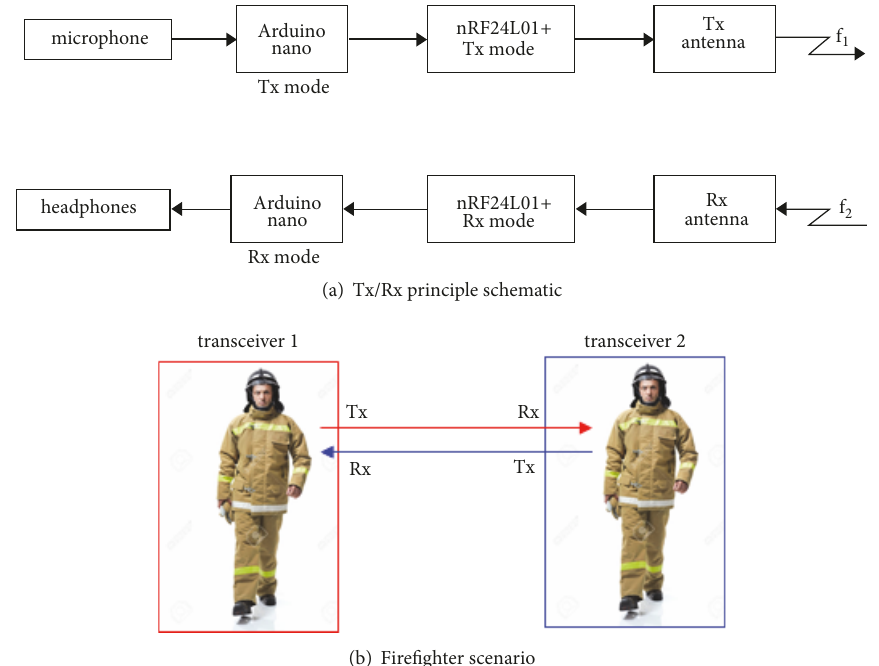
Figure 3: Realization of a full-duplex voice link using Arduino nano and nRF24L01+ transceiver: (a) the principle schematic; (b) a possible implementation scenario. Image source for the firefighter: 123RF .